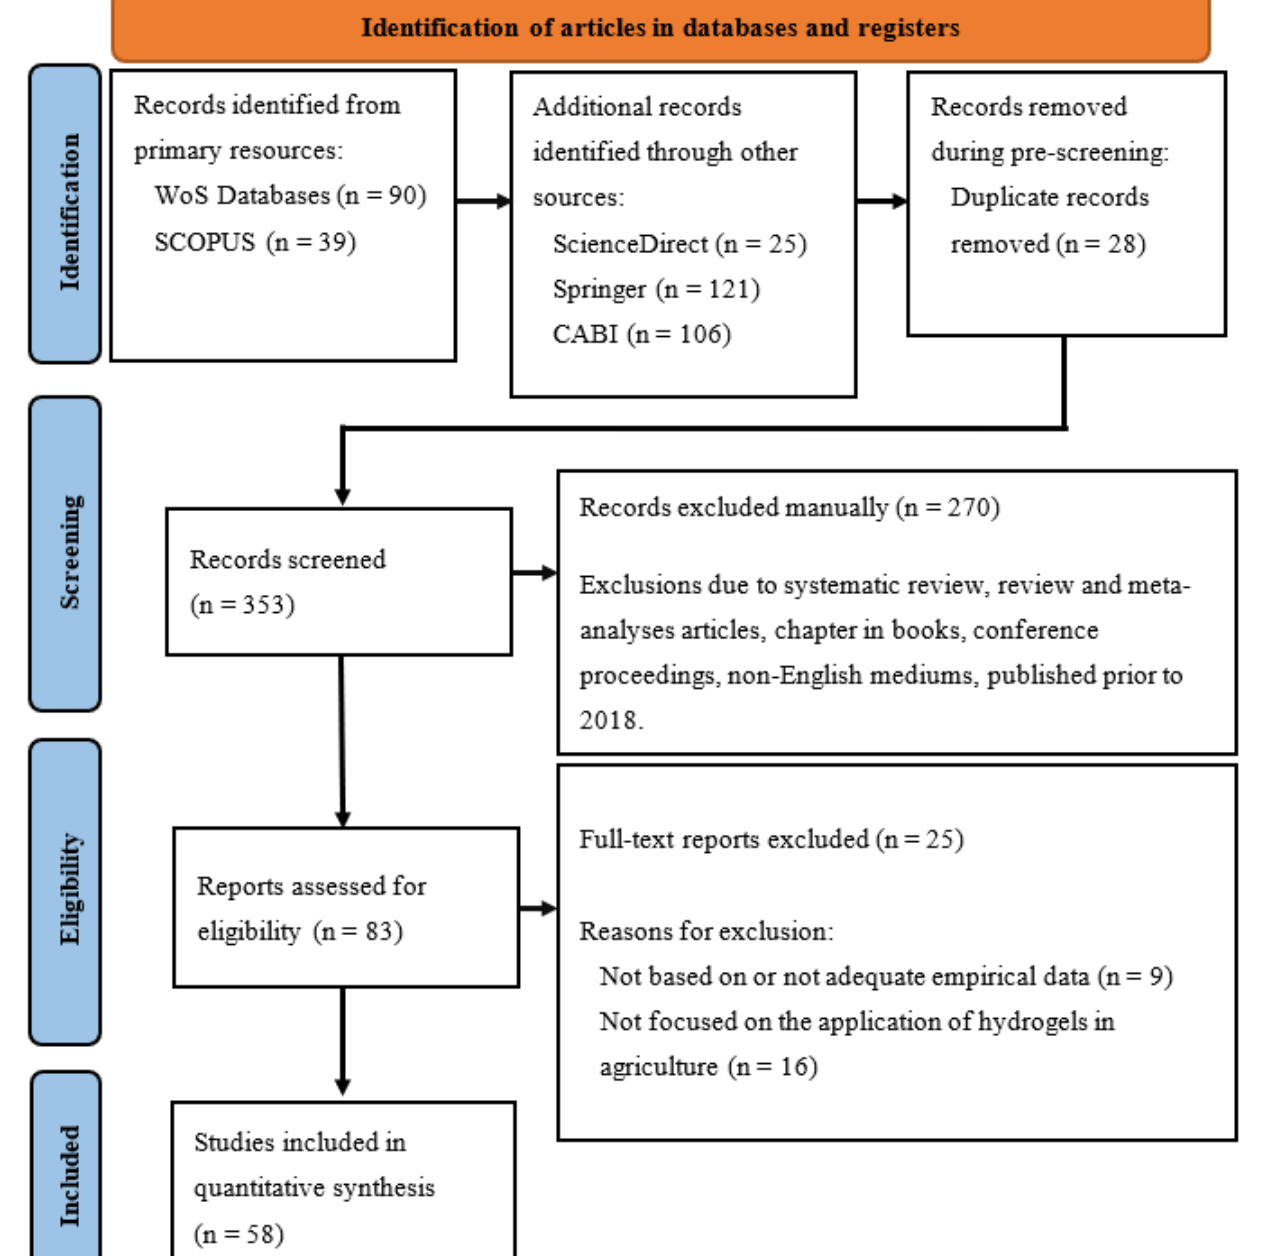
Figure 1. The PRISMA flow diagram of the study *. * Note: Adapted from [39].